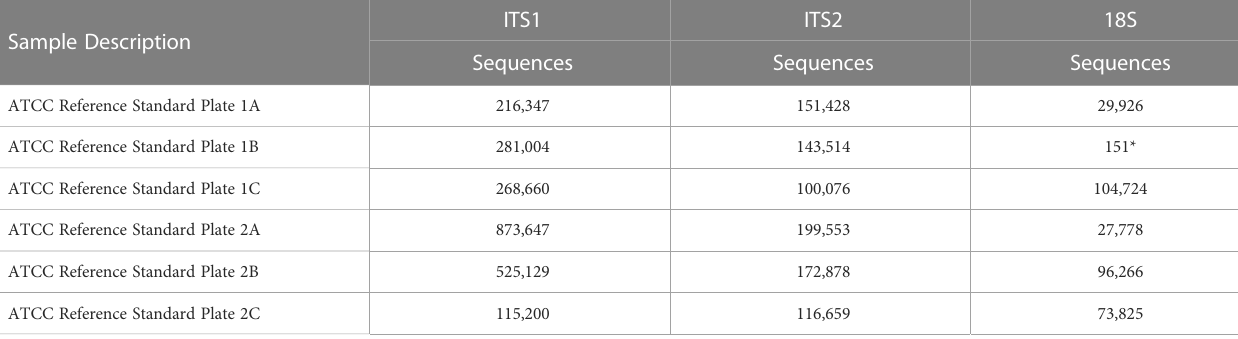
TABLE 2 ITS1, ITS2, and 18S sequencing results for fungal mock